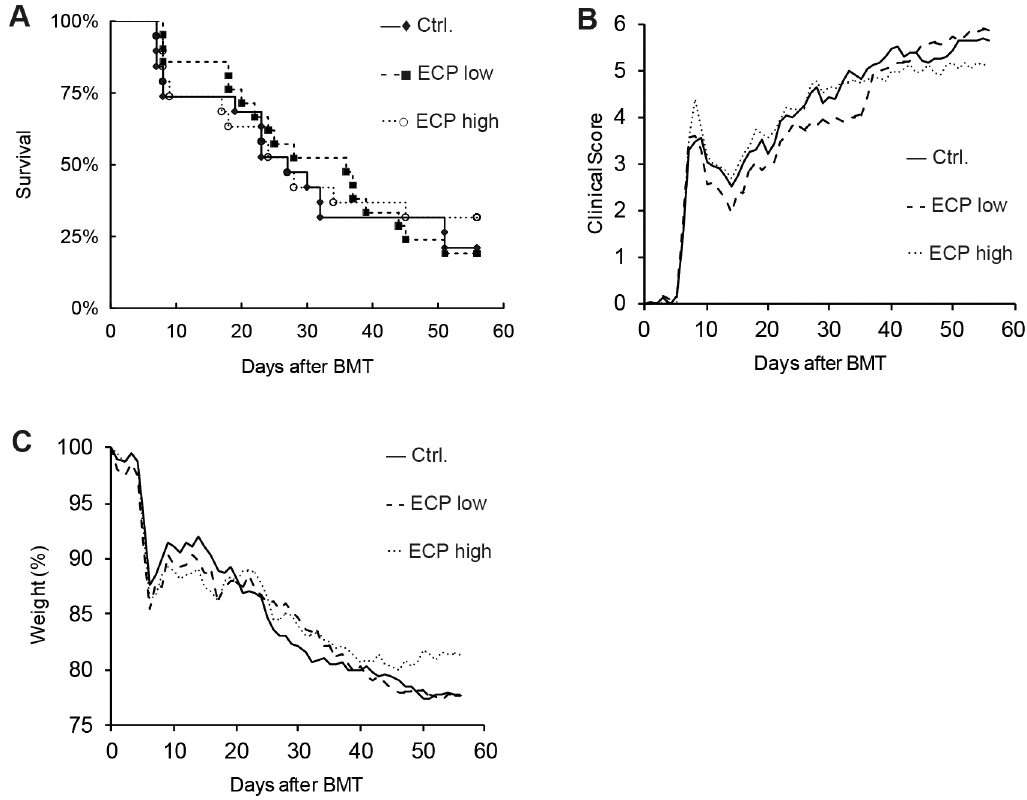
Figure 5. Modified ECP therapy for acute GvHD. Modified ECP therapy was performed as treatment for acute GvHD induced by C57BL/ 6 R BALB/c bone marrow transplantation. ECP cells were isolated from wild type B6 spleens and treated with 8-Methoxypsoralen (8-MOP) and UV-A light. Treated cells were injected 4 times in C57BL/6 R BALB/c transplanted GvHD mice at weekly intervals starting from day 1 after BMT. For each therapeutic injection, 8-MOP/UV-A treated cells were used either in low concentration of 1 6 10 6 cells ( --- & ) or in high concentration of 5 6 10 6 ( ??? # ) cells. Control animals ( — ¤ ) were transplanted simultaneously and injected with PBS only at therapeutic time points. Therapeutic impact and GvHD severity were analyzed by comparing survival rates (A), clinical GvHD symptom score (B) and weight loss